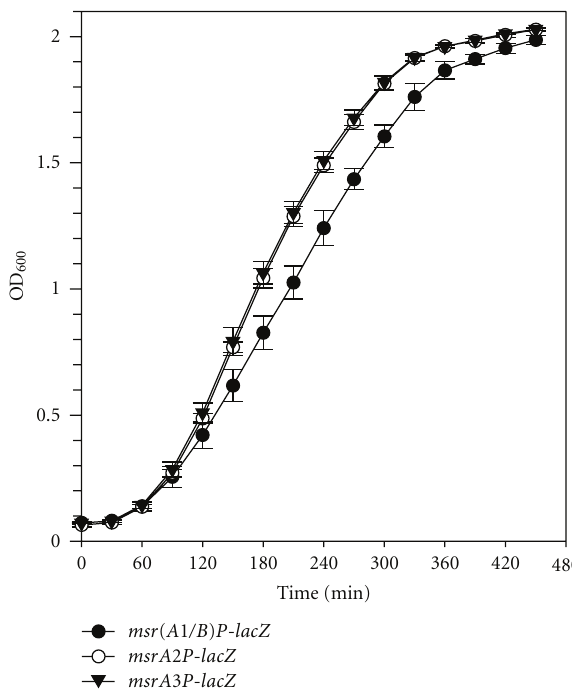
Figure 1: Growth comparison of the msr(A1/B)P-lacZ , msrA2P- lacZ , and msrA3P-lacZ reporter constructs in S. aureus strain SH1000. Growth was measured by recording OD 600 periodically. Values indicate averages of data from three independent experi- ments ± standard deviation (SD). The msr(A1/B)P-lacZ , msrA2P- lacZ , and msrA3P-lacZ reporter strains are represented by closed circles, open circles, and closed triangles,